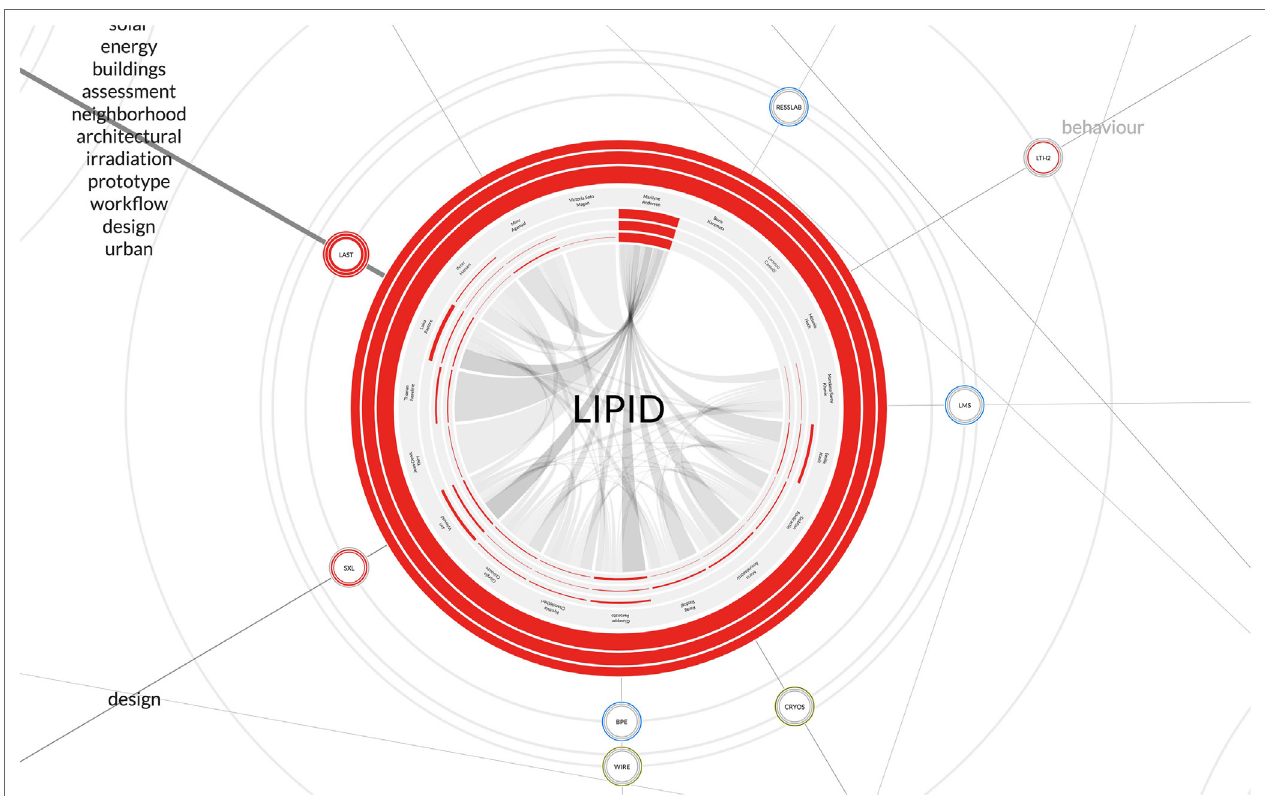
FigUre 4 | Satellites are the graphical elements that convey link heterogeneity. Their rings represent from the inner advising, publications, and teaching. Furthermore, satellites create an ego-network that summarizes all the actual